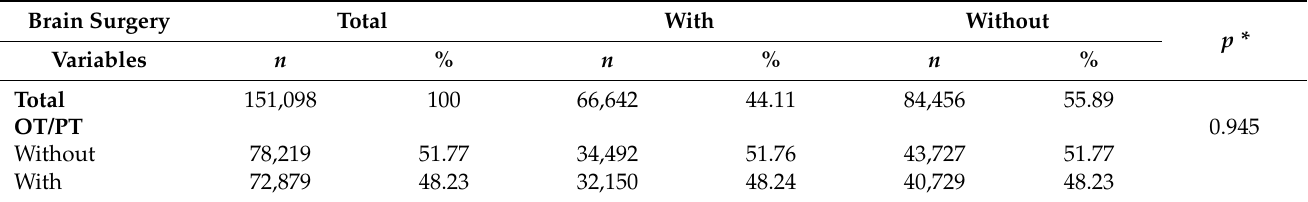
Table 5. Crosstab of brain surgery and OT/PT in the TBI cohort.